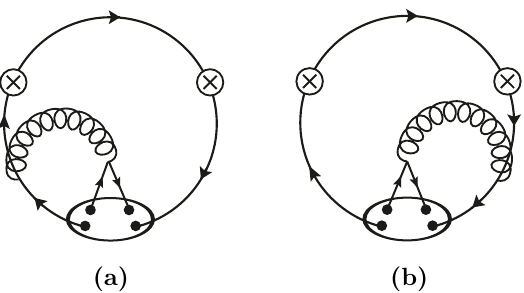
Figure 17. Feynman diagrams of the contribution of the four-quark condensate to the two-point Green functions due to the e(cid:11)ective propagation of the nonlocal quark